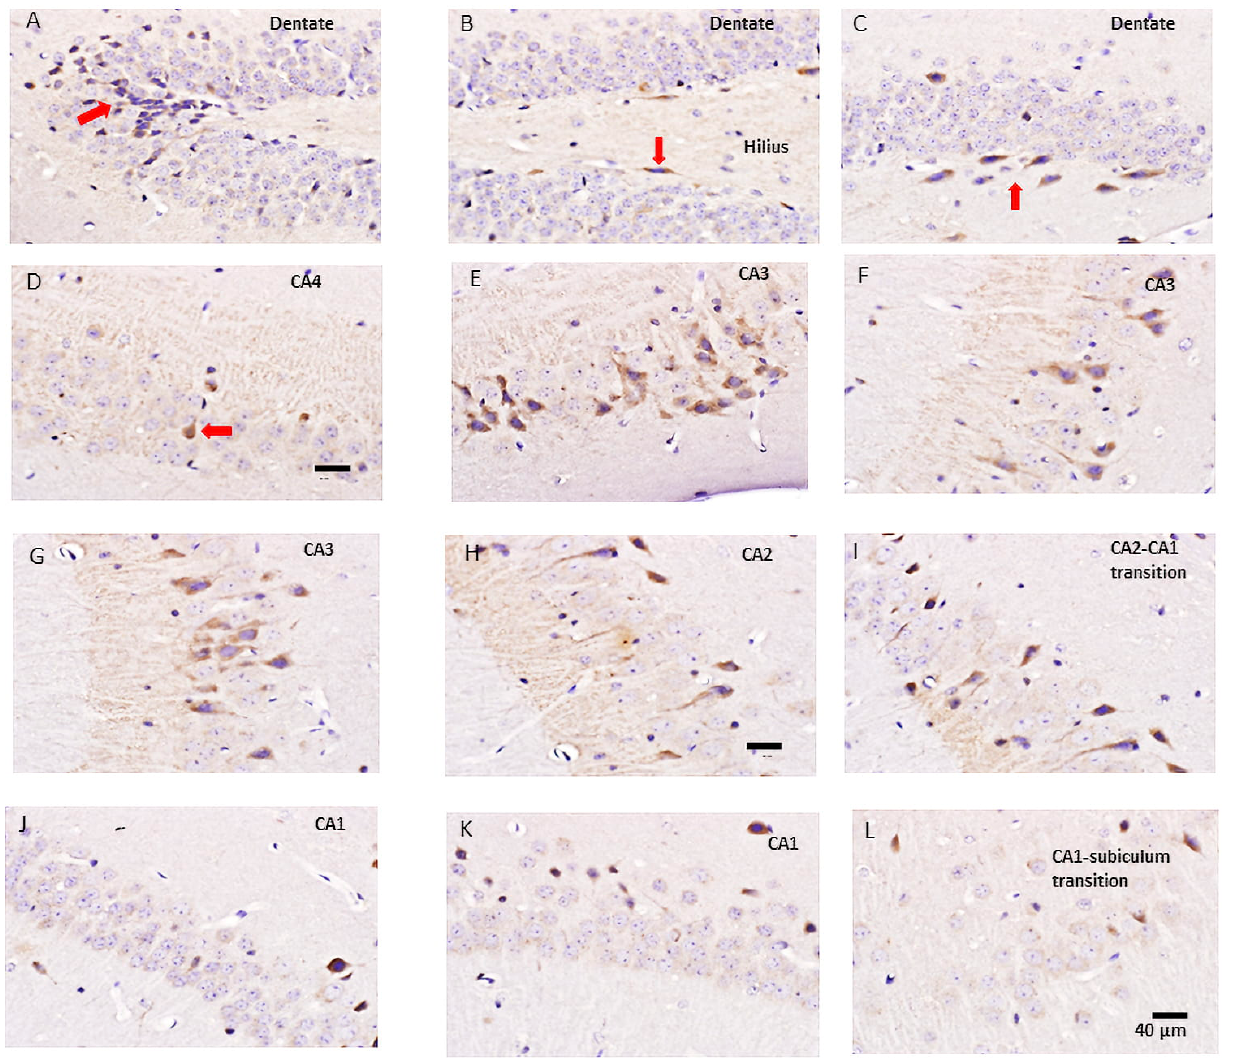
Fig. 4. Ab staining of cells in different regions of the hippocampus. (A) Shows the beginning of the DG in which most of the small round cells (i.e., granulecells)areunstainedbytheanti-PIEZO2Ab. However,therewasaclusterofstainedcellsatthecrest/tipofthegyrus(redarrow). (B)Showstheadjacent region of the DG in which only 2–3 spindle-shaped cells (one indicated by red arrow) located in the subgranular zone show Ab staining. (C) A continuing region further along the DG showing 7 spindle-shaped cells stained by the anti-Piezo2 Ab. At least in this slice, the DG region only showed 16 out of 1149 cells with clear brown staining (i.e., 1.4%). (D) Shows the hilus/C4 region with at least one darky-stained cell (red arrow) but only 2 out of the 72 neurons Ab stained. (E–G) In this slice, the CA3 region showed the highest density of Ab staining, with 50 out of 140 cells stained (36%) and displayed unitary thick processes (i.e., apical dendrites) consistent with pyramidal neurons. (H) The CA2 region shows a somewhat lower density of stained neurons, with 15 out of 71 cells stained (22%). (I) A region near the CA2-CA1 transition displays a further reduced density of stained neurons (23/305, i.e., ~8%). (J–K) CA1 regions showing even fewer stained neurons. (L) CA1 region transitioning into the subiculum that displayed no Ab-stained